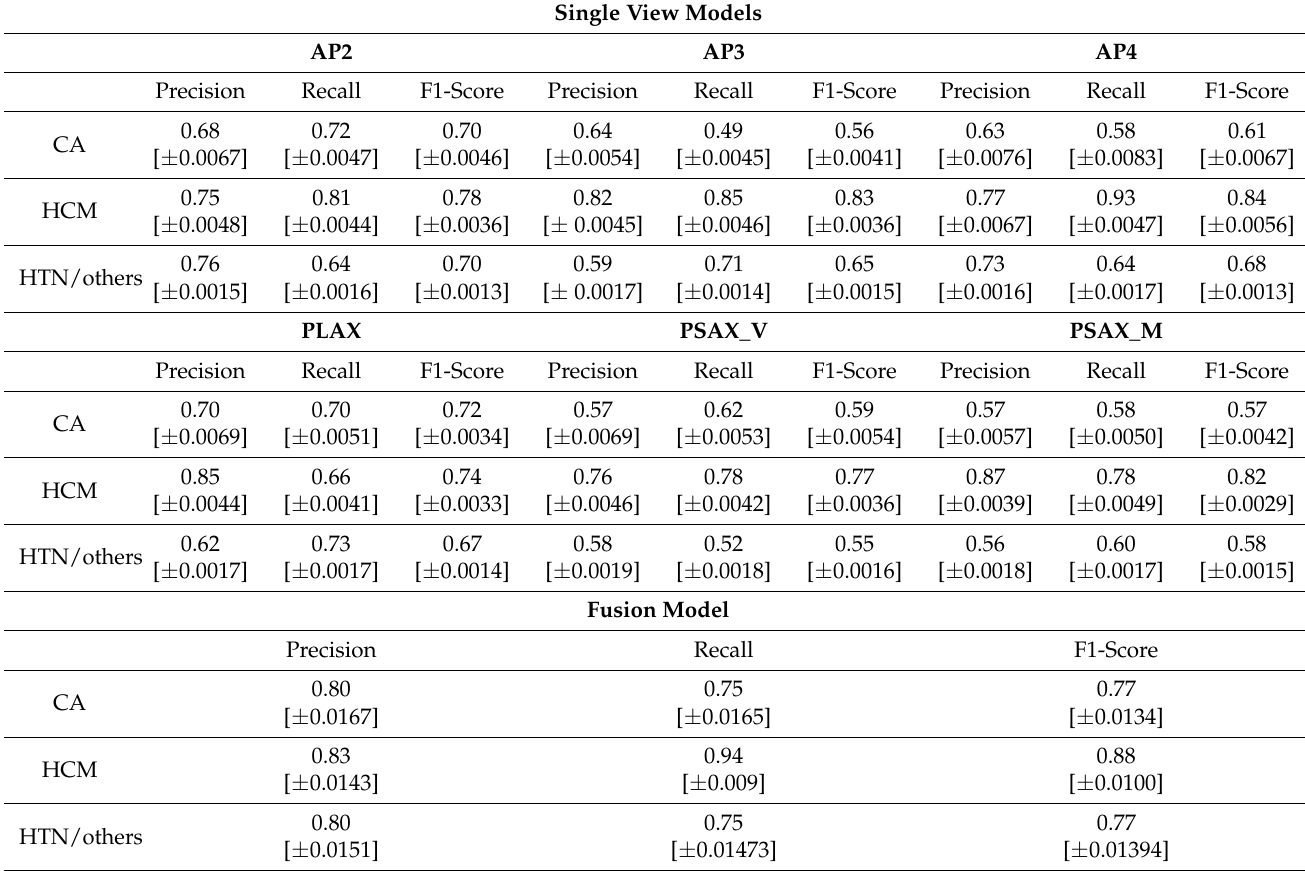
Table 2. Quantitate class-wise performance analysis for the single view and fusion model on the same hold out test set. 95% confidence interval was calculated using